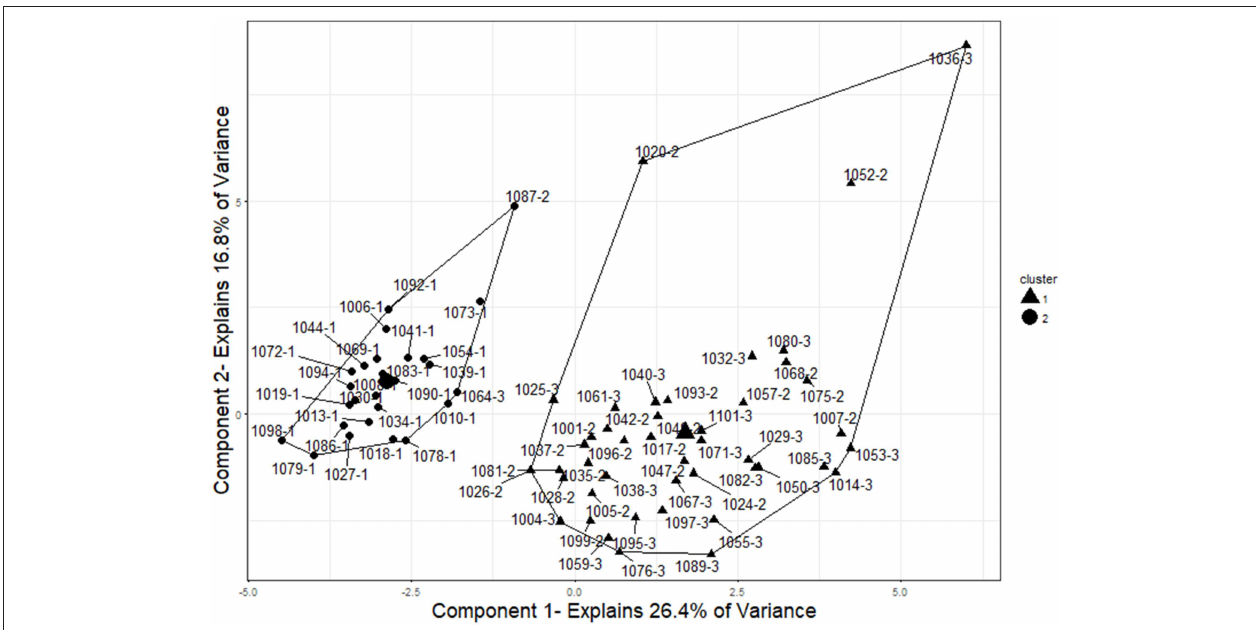
FIGURE 6 | Two-cluster solution for examinees. The two clusters represent good separation between control (IDs that end in − 1), ItemOnly (IDs that end in − 2), and Item + Answer (IDs that end in − 3) participants. Two examinees were grouped incorrectly by this analysis (1064-3 and 1087-2). The cluster centers and cluster membership are indicated by shape (circles represent the cluster of size 26 and triangles represent the cluster of size 44). To visualize the cluster results, components were obtained using principal component analysis, and the clusters are plotted on those components. This plot was created using the “fviz_cluster” function in the “factoextra” package of R ( Kassambara and Mundt, 2017).